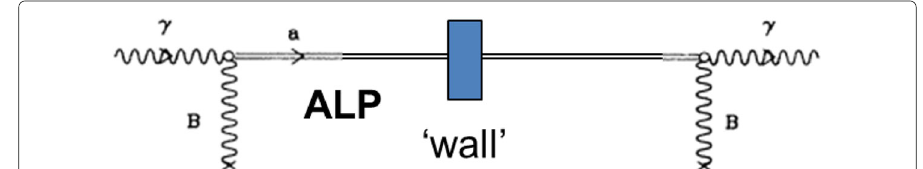
Fig. 1 Physics principle of the experiment. Laser photons interact with the magnetic field B to create an axion like particle. The ALP penetrates the material wall and occasionally reconverts to a photon in the magnetic field behind the wall, to be detected by a photon